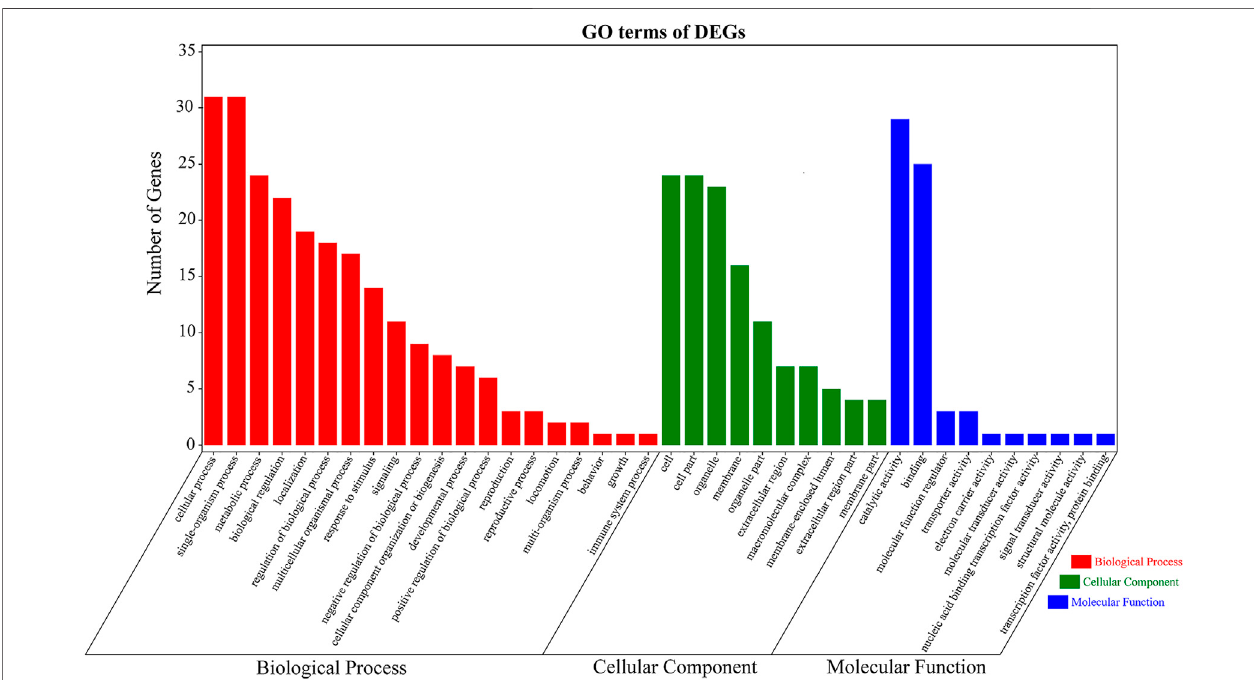
FIGURE5| GeneOntology(GO)termsof489differentiallyexpressedgenes(DEGs)forthetranscriptomesof Litopenaeusvannamei .The x -axisindicatesthename ofGOsubcategories.The y -axisindicates thenumber ofgenes.Redindicatesbiologicalprocess. Green indicates cellular component. Blue displays molecular function.